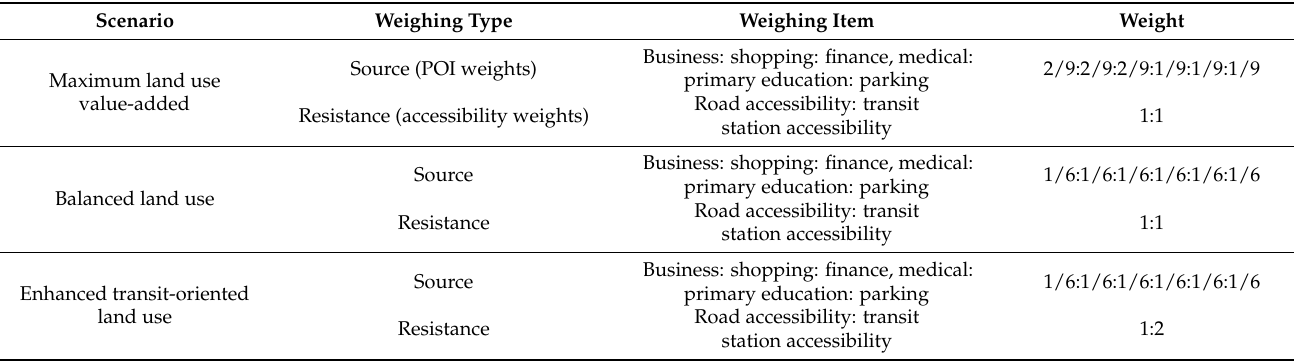
Table 2. POI weighting in the three planning scenarios.